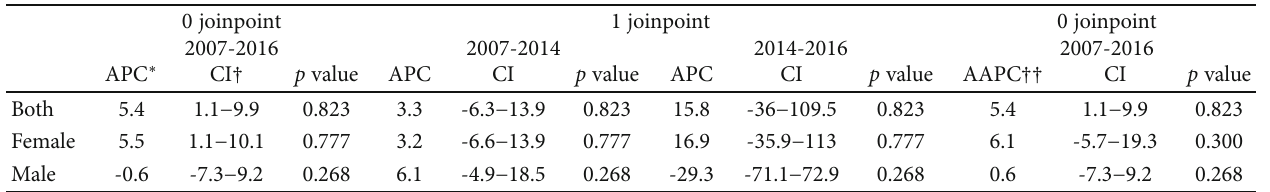
Table 3: Trend analysis of age-standardized incidence rates (ASIRs), breast cancer patients in Northwest of Iran, between 2007 and 2016 in both sexes (per